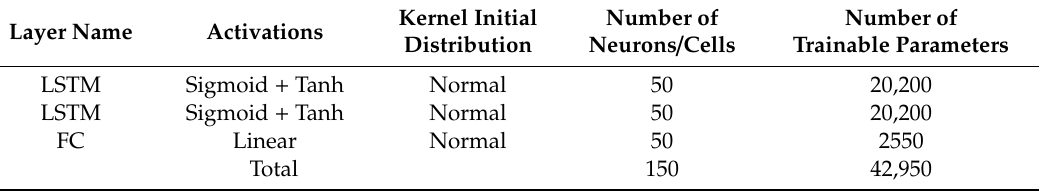
Table 2. GRU model